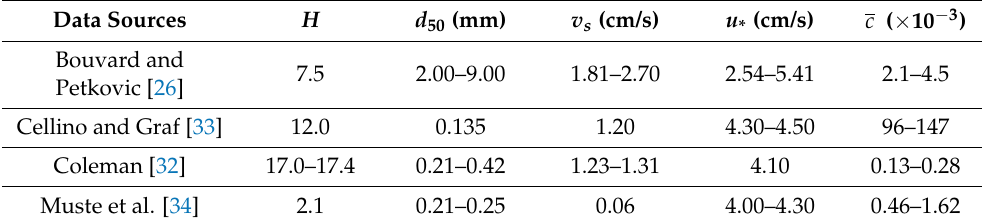
Table 1. Sources of data for parameterised modelling